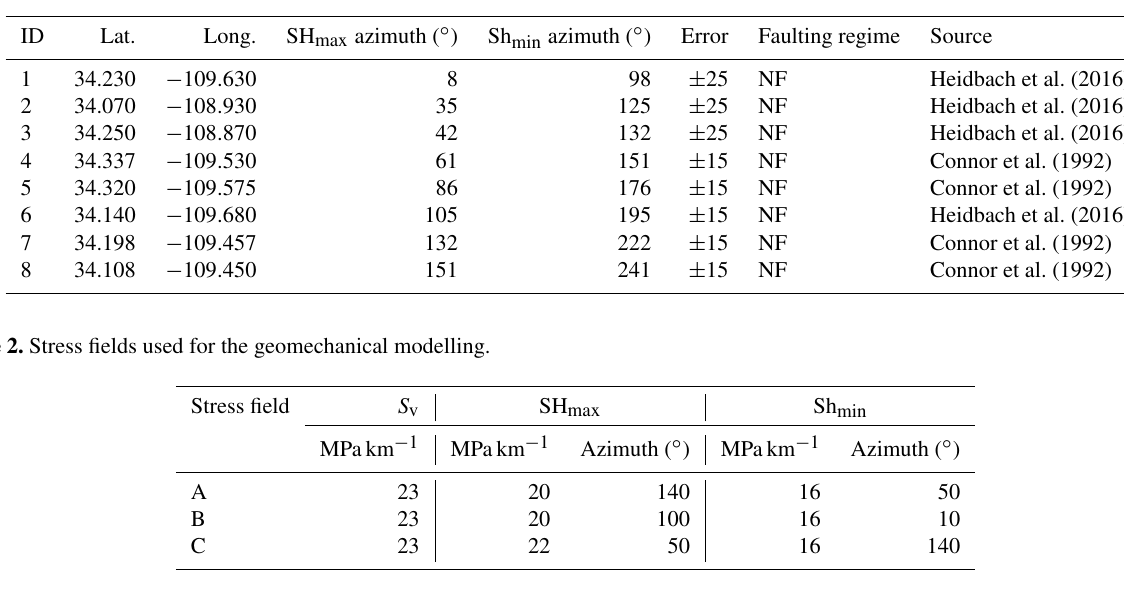
Table 1. Table listing published stress field indicators around the St. Johns Dome. They form three clusters: IDs 2–4; 5 and 6; 7 and 8. WSM is the World Stress Map.